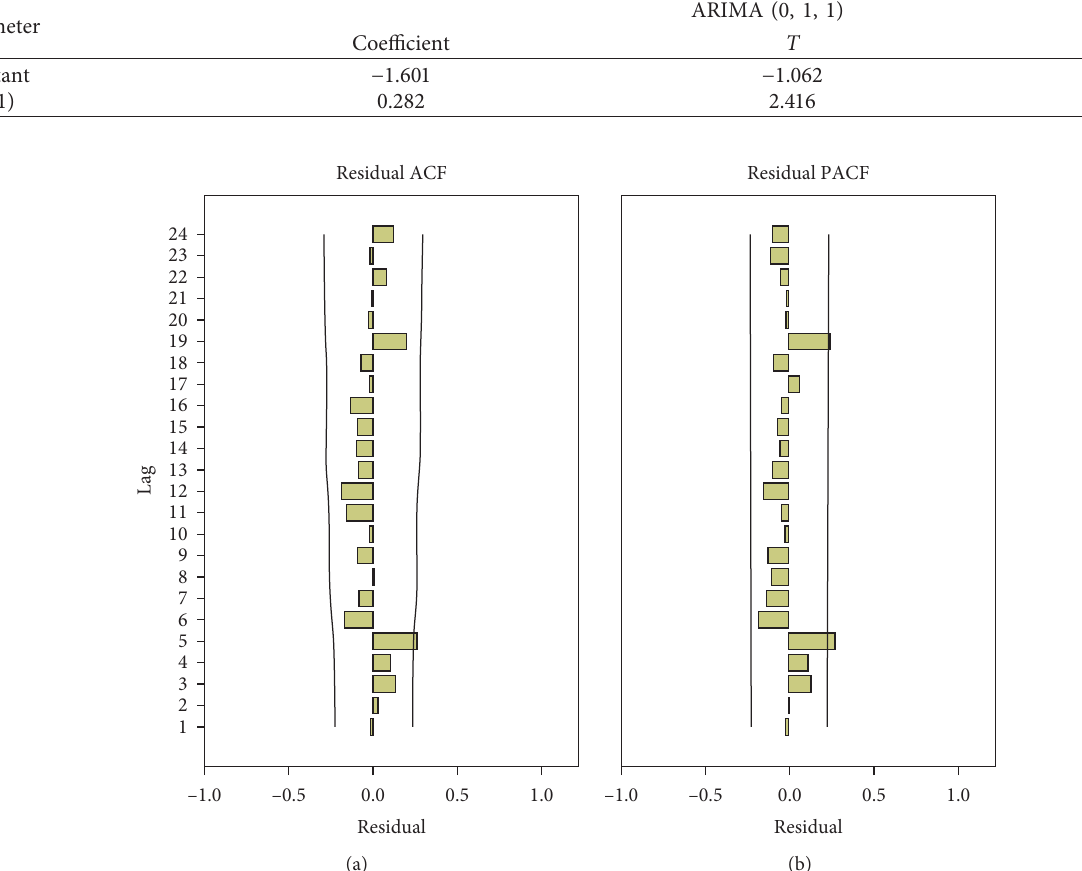
Figure 13: Autocorrelation and partial autocorrelation plots of the residuals. (a) Autocorrelation. (b) Partial autocorrelation.